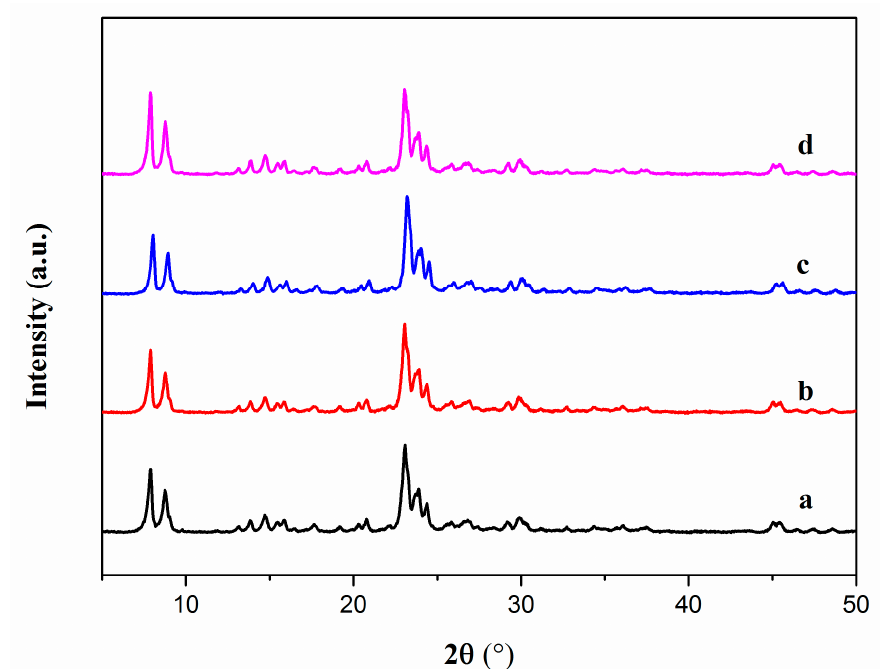
Figure 1. XRD patterns of HZSM-5 catalysts with different Na/Al ratios in synthesis gels. ( a ) HZ(0), ( b ) HZ(0.4), ( c ) HZ(0.8), and ( d ) HZ(1.1). Table 1. Crystallite and lattice parameters of catalysts.